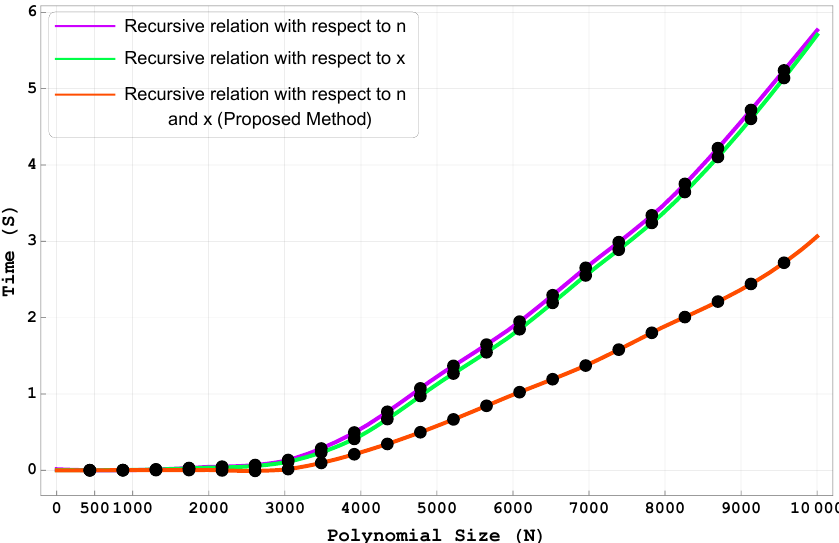
Figure 14. Computation time of the KPs using the proposed four-term recursion and existing three- term recursions. The minimum and maximum KPs sizes are 500 and 10,000, respectively. Assuming p =